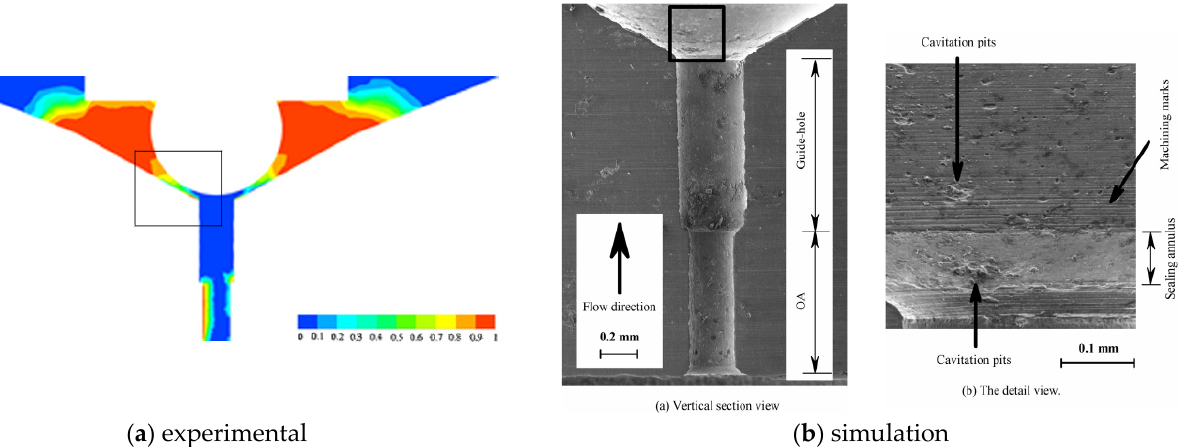
Figure 5. Comparison of fatigue test cavitation damage of control valve seat with simulation observed by scanning electron microscope.